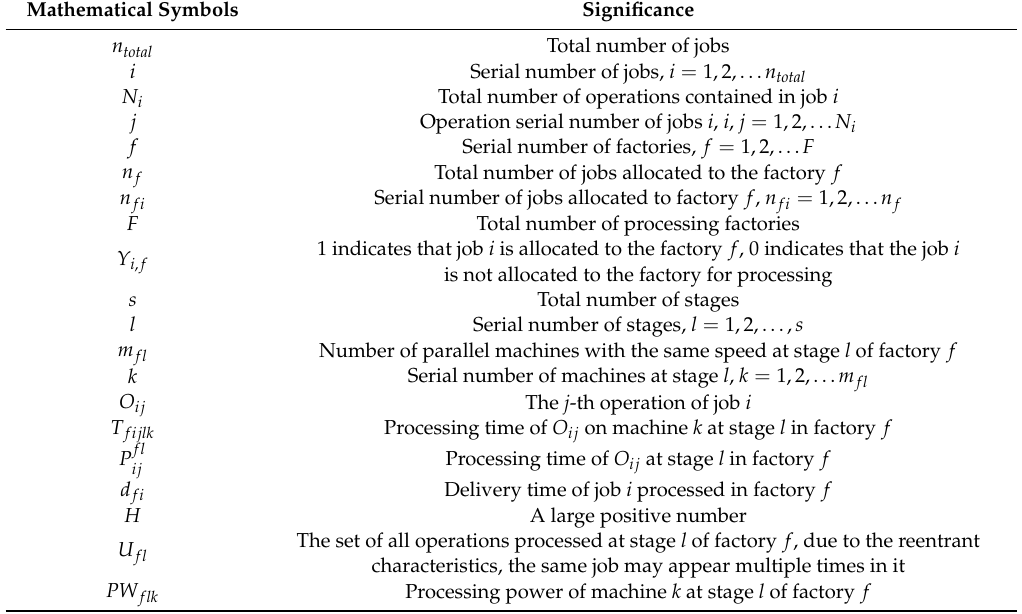
Table 1. Mathematical symbols and